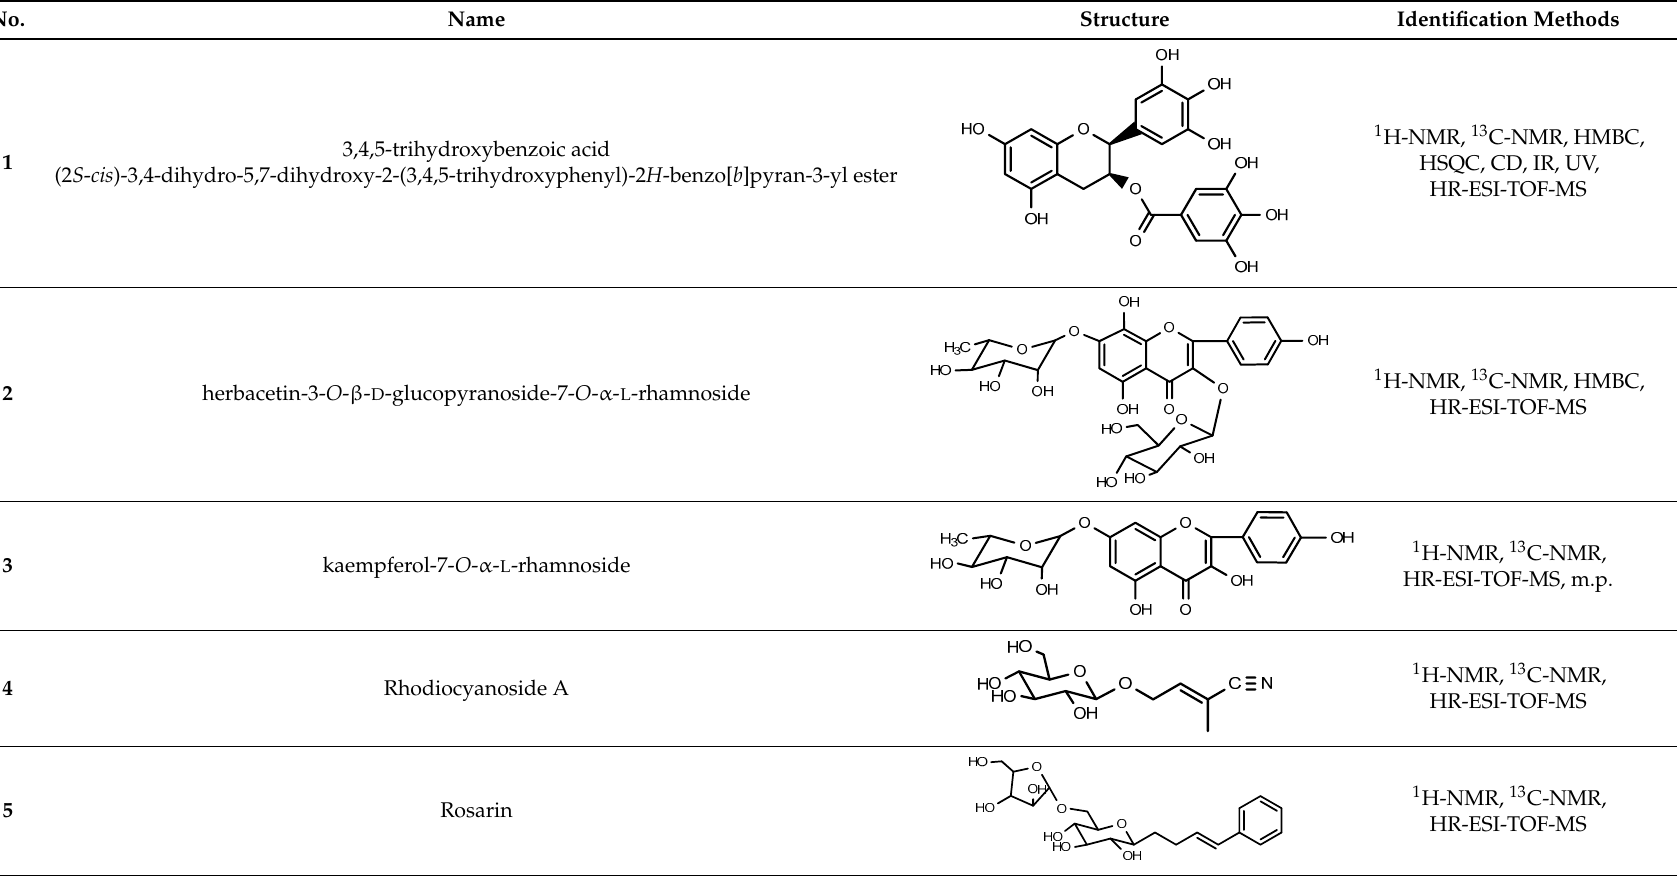
Table 2. The structures of compounds in Rhodiola rosea L.